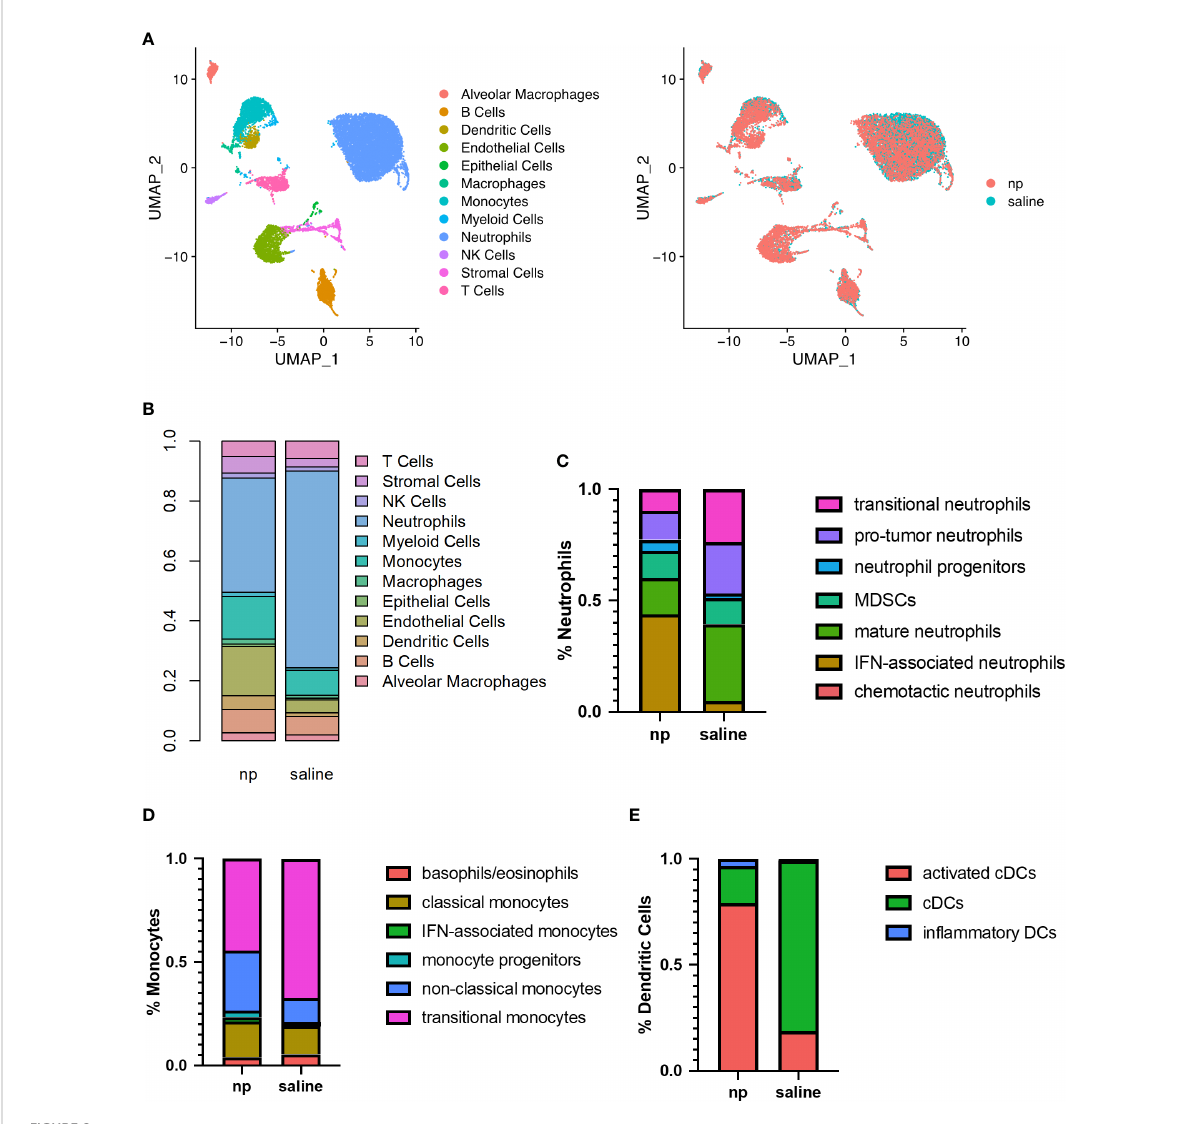
FIGURE 2 Remodeling of immune milieu at lungs due to NP administration in vivo . The lungs of 4T1-bearing mice receiving NPs or saline (n=4 per group) analyzed by single cell RNA sequencing. (A) UMAP plot of clustering of single cells by identi fi ed cell populations (left) or by treatment condition (NP vs saline, right). (B) Histogram of cell populations at the lungs as percentage of total cells. Proportion of (C) neutrophil, (D) monocyte, and (E) dendritic cell subsets at the lungs of mice receiving NPs or